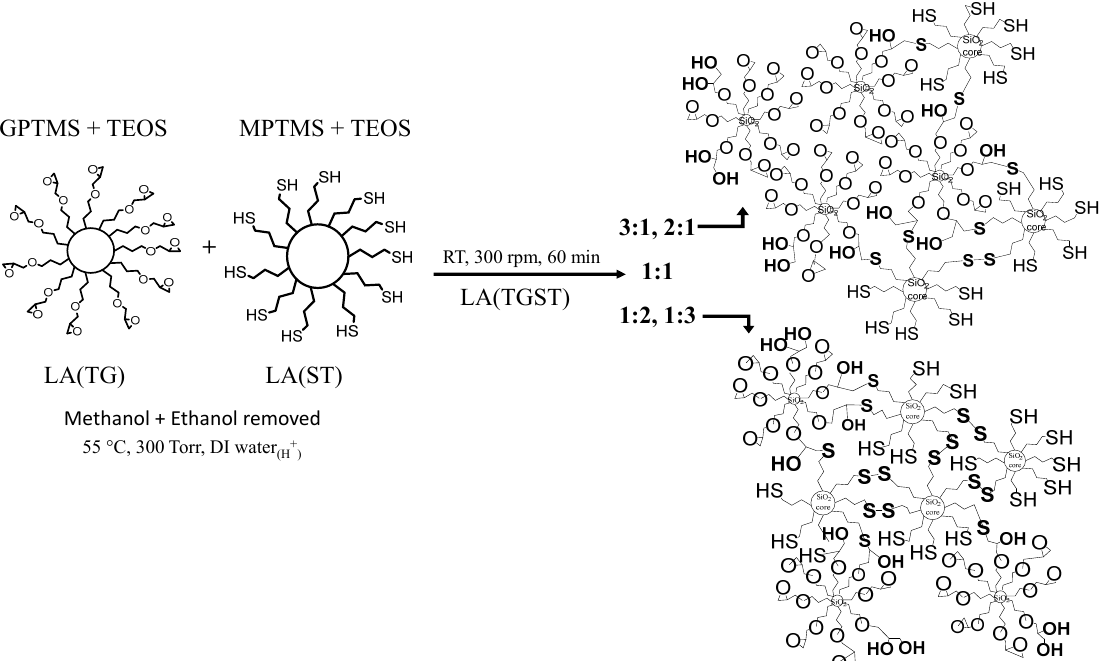
Scheme 1. Schematic microstructure and pathway for the crosslinking of low-alcohol LA(TG) and (LA)ST precursors to form the LA(TGST) system in five ratios. TG: epoxy silicate, ST: thiol silicate.